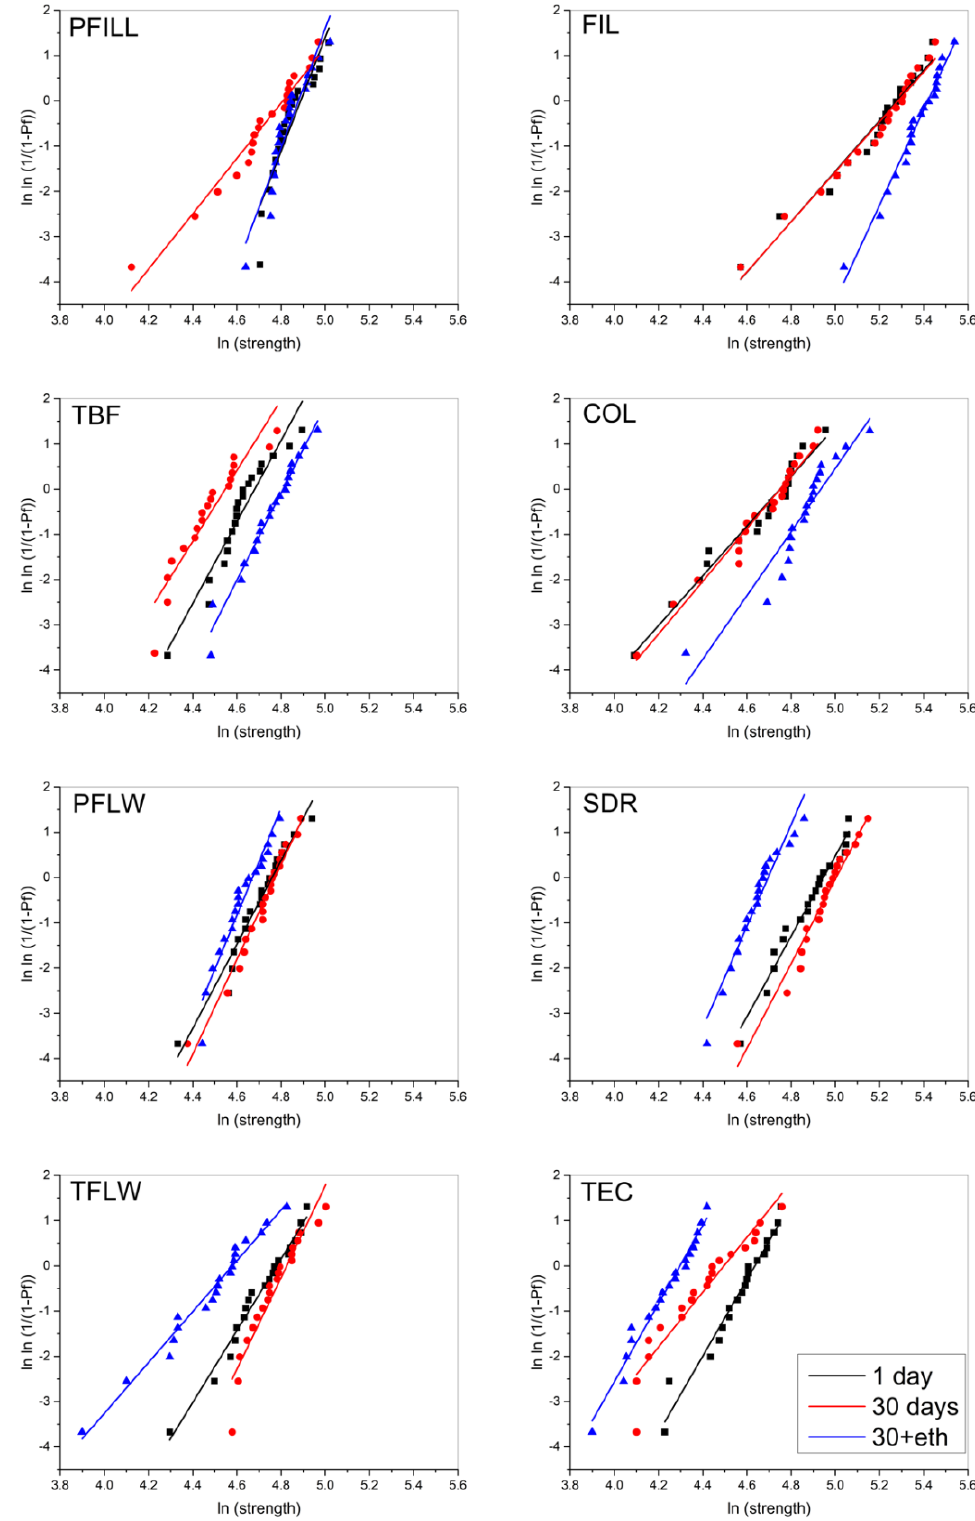
Figure 4. Weibull plots for the analysis of material reliability after artificial aging. Triangle, cirlcle and square represent individual time points.